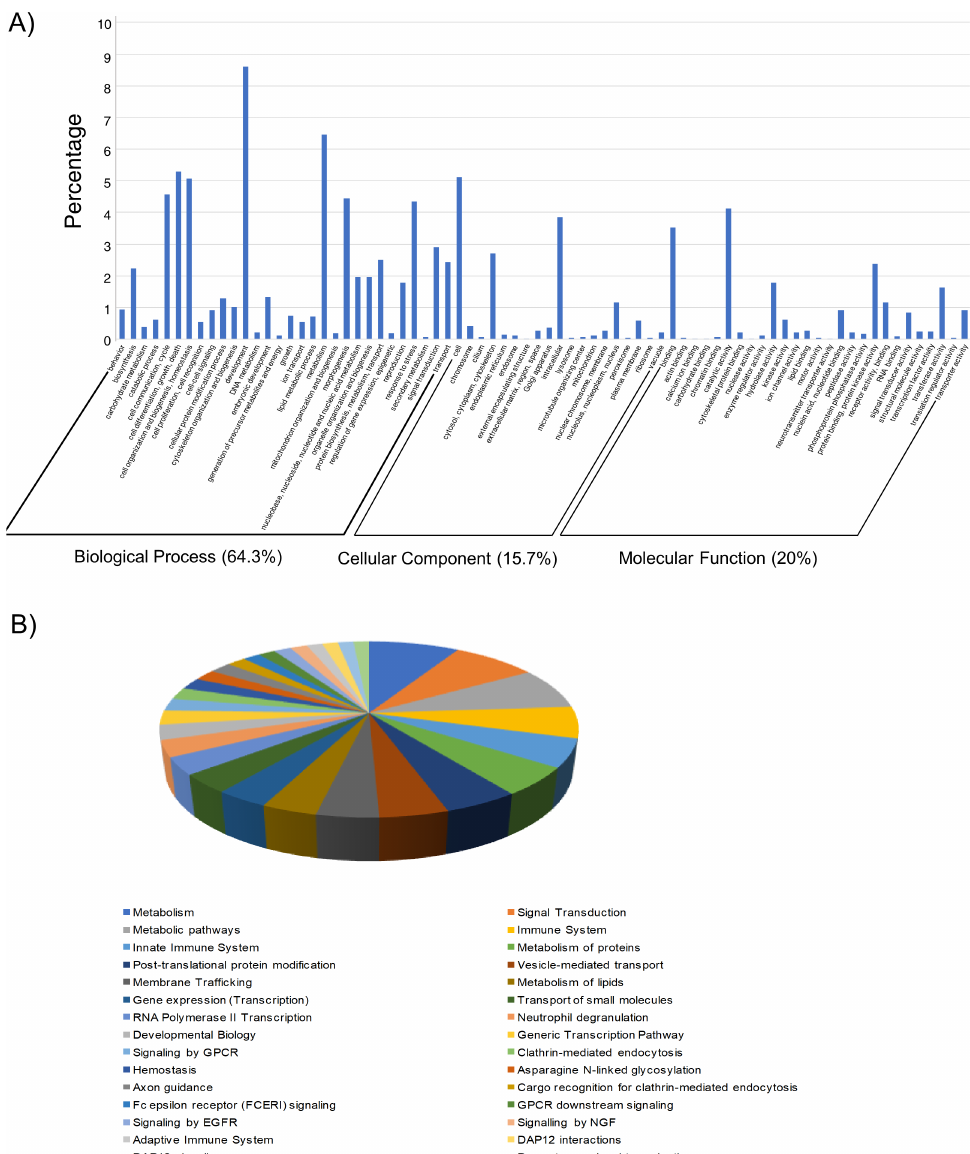
Fig 2. Gene ontology (GO) analysis and pathway annotation of the most targeted genes of the known differentially expressed miRNAs between 91-R and 91-C strains. (A) GO analysis. 664 target genes from miRNAs predicted to be differentially expressed were analyzed with FlyMine to obtain the GO terms, and the GO terms were classified with CateGOrizer and separated into three major categories. (B) Pathway annotations. 664 target genes from miRNAs predicted to be differentially expressed were submitted to FlyMine to get the pathway classification. The 30 most abundant pathways were